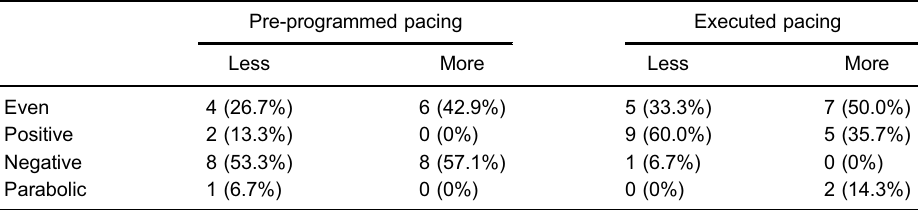
Table 2. Pre-programmed and executed pacing in less and more experienced race walkers.